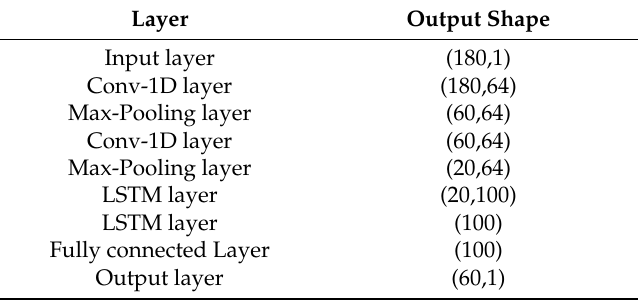
Table 3. The output data format of the input layer, each intermediate layer, and the output layer in DWT-CNN-LSTM model.